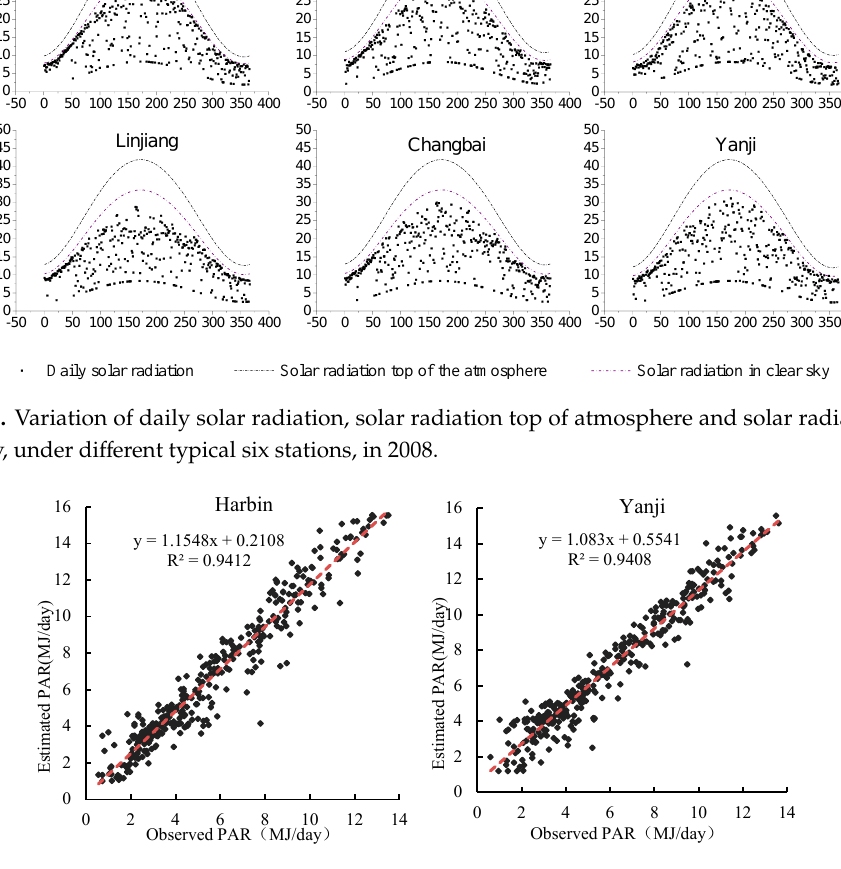
Figure 4. Comparison of daily estimated photosynthetically active radiation (PAR) and observed PAR in Harbin and Yanji stations, in 2008.